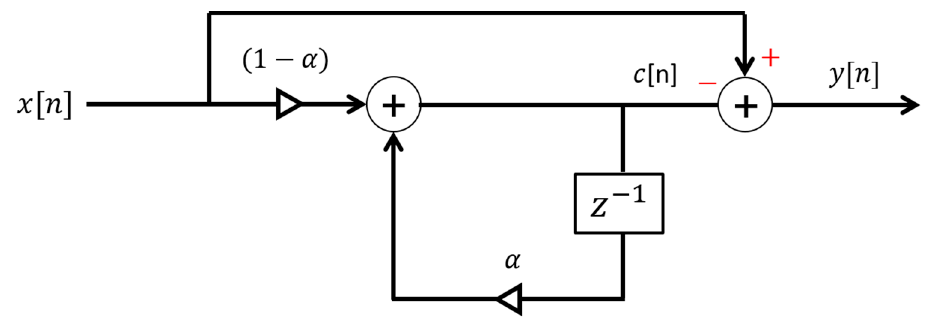
Figure 3. Loopback filter for clutter removal.